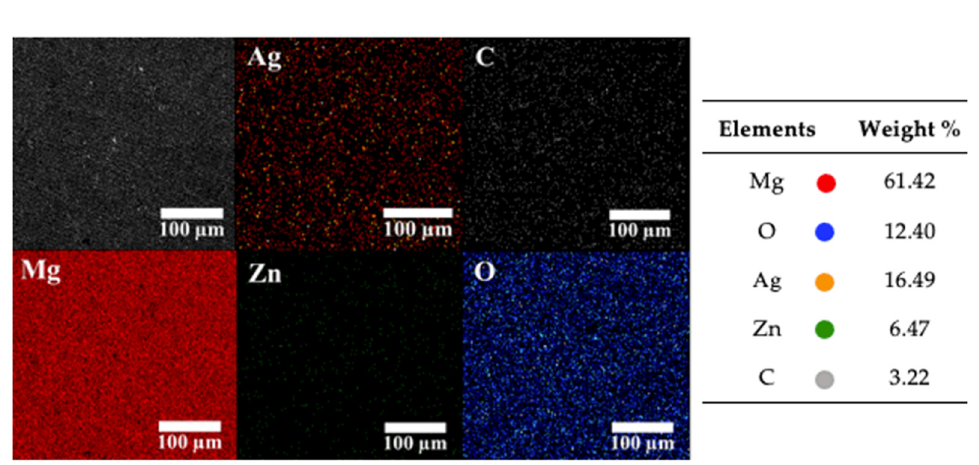
Figure 11. EDS maps (200 × ) of the elements present in the hybrid ZnO/Ag deposits on Mg–Ca0.3 surfaces, electroless achieved from aqueous solutions (10 − 3 M, at 21 °C) ZnO/AgNO 3 .